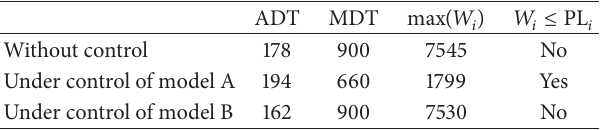
Table 5: Comparison of key indicators.